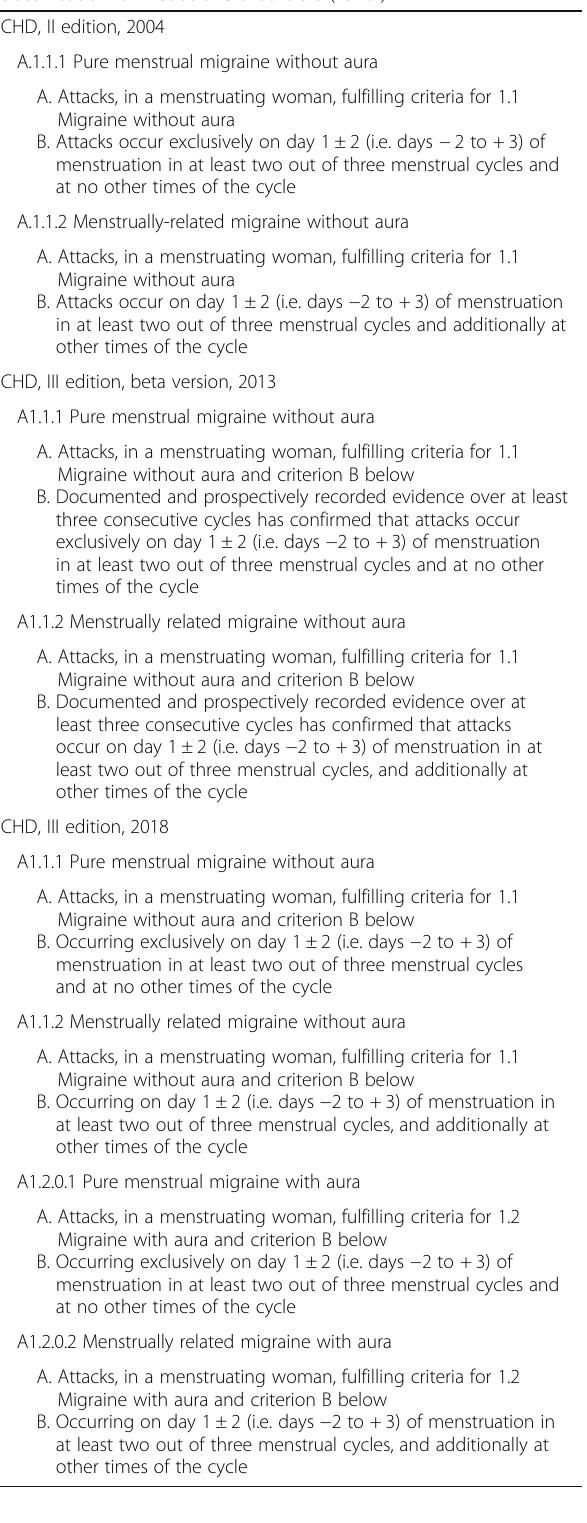
Table 1 Diagnostic criteria of migraine related to menstruation according to the different editions of the International Classification of Headache Disorders